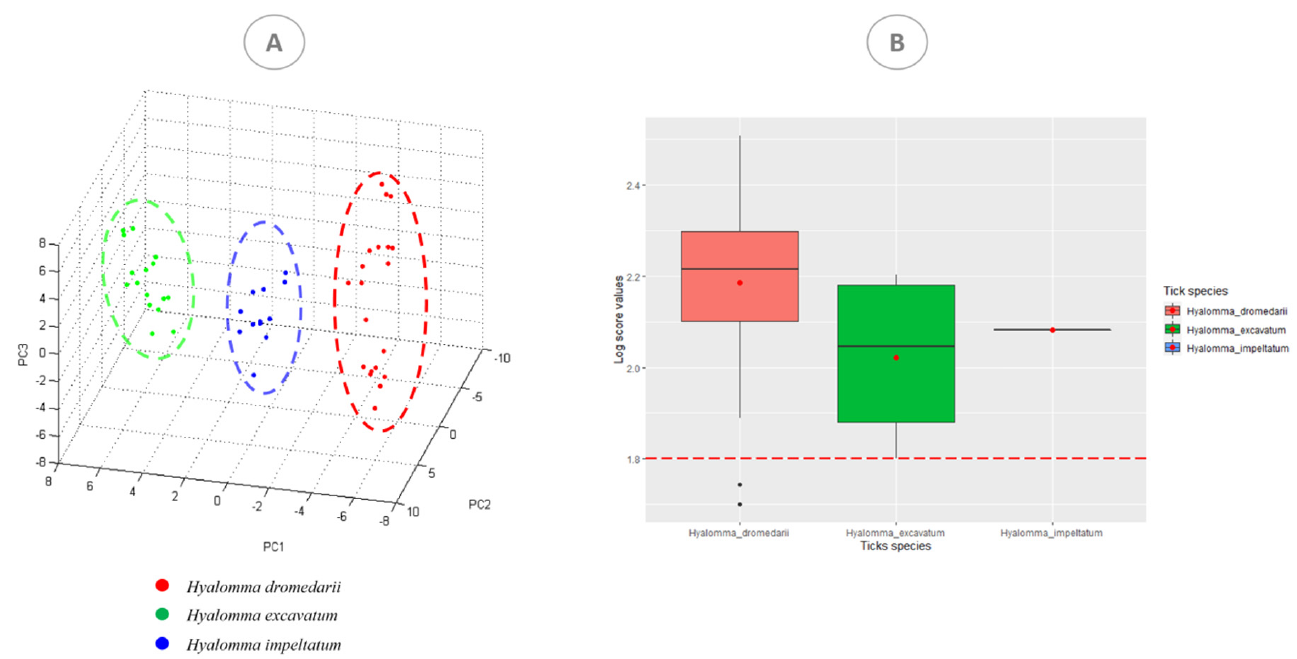
Figure 3. MALDI-TOF MS spectra obtained from tick species. ( A ) Comparison of MALDI-TOF MS spectra of three species by principal component analysis using ClinProTools 2.2. ( B ) Graphical repre- sentation showing the log-score value classification according to the present species: H. dromedarii , H. impeltatum and H. excavatum .